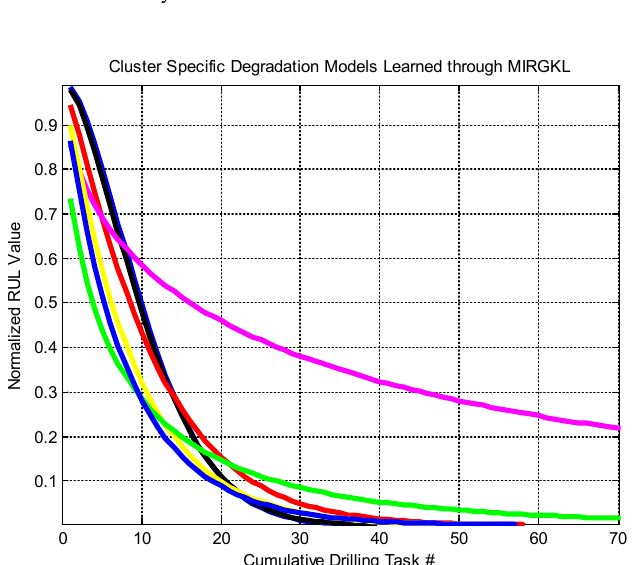
Figure 11. Learned cluster-specific degradation models of clusters with 3% (10 points) of all data points. Each color represents one specific cluster’s learned degradation profile.